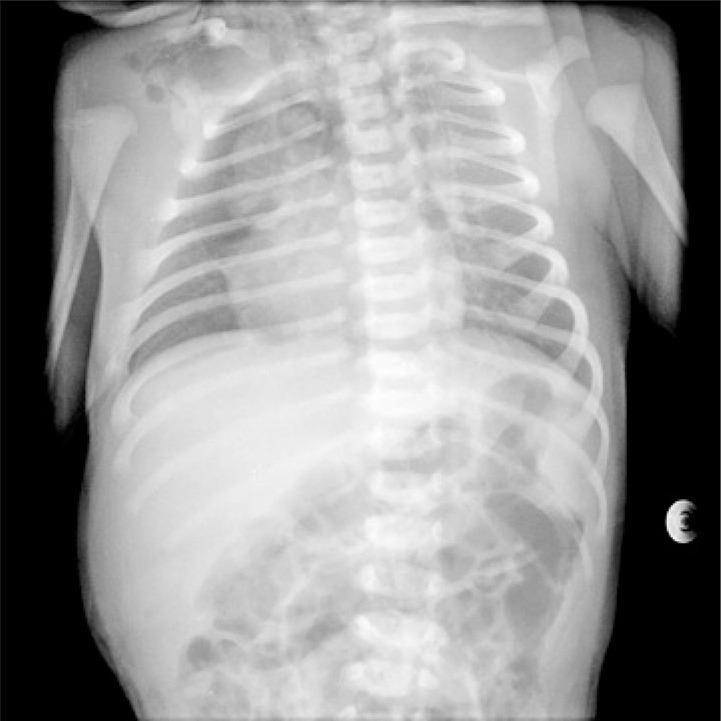
Radiografia de tórax mostrando o sinal de “vela de Spinnaker” (cunha hipotransparente que se estende até ao mediastino superior, delimitada inferiormente por zona hipertransparente)